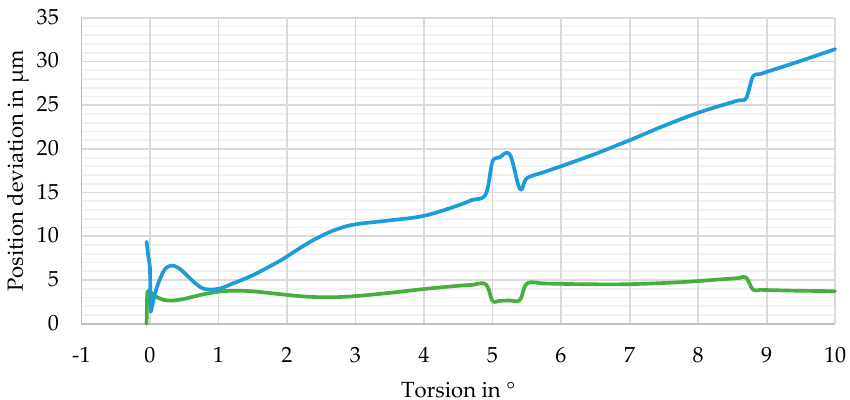
Figure 16. Influence of the thermal expansion (+10 K) of the rod on the exit position of the laser beam. Green: relative approach, blue: absolute approach.